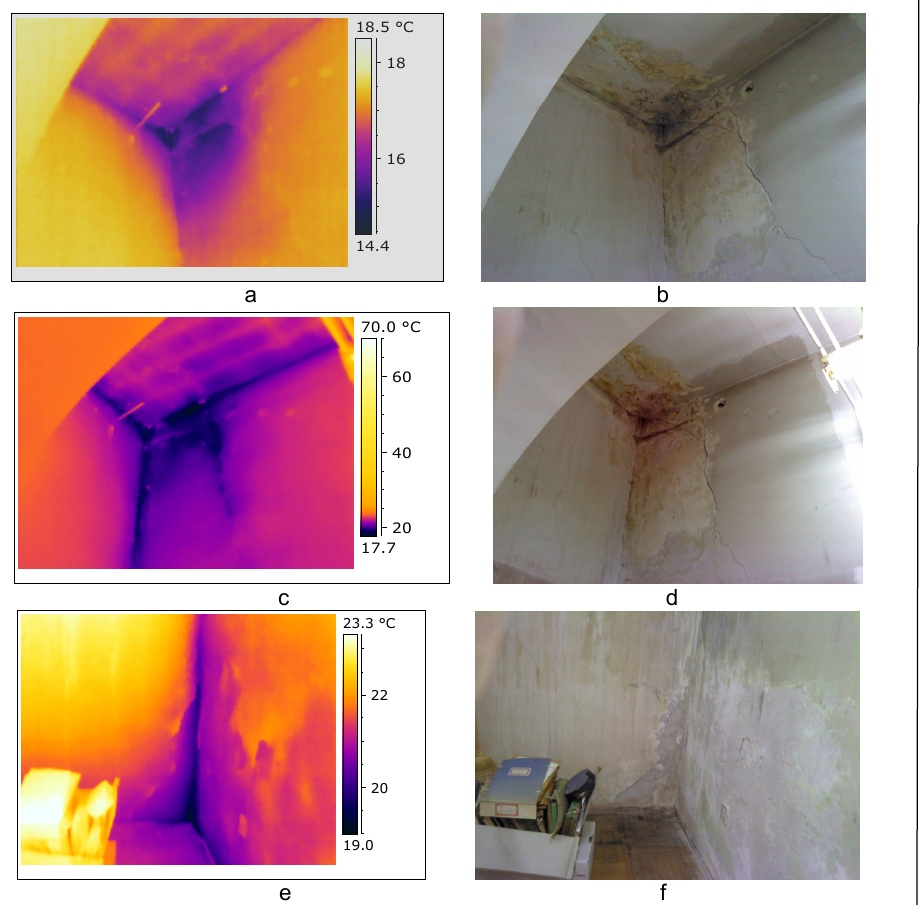
Figure 1 – Moisture in the far left corner of the library in relation to the front door, a,b-thermogram and the photo in the October test, c,d-thermogram and the photo in the November test, e and f- the lower part of the same corner during the second test Slika 1 – Vlaga u levom krajnjem uglu biblioteke u odnosu na ulazna vrata, a,b-termogarm i fotografija snimljeni u oktobru, c,d- termogarm i fotografija snimljeni u novembru, e, f-donj deo istog ugla snimljeni u drugom